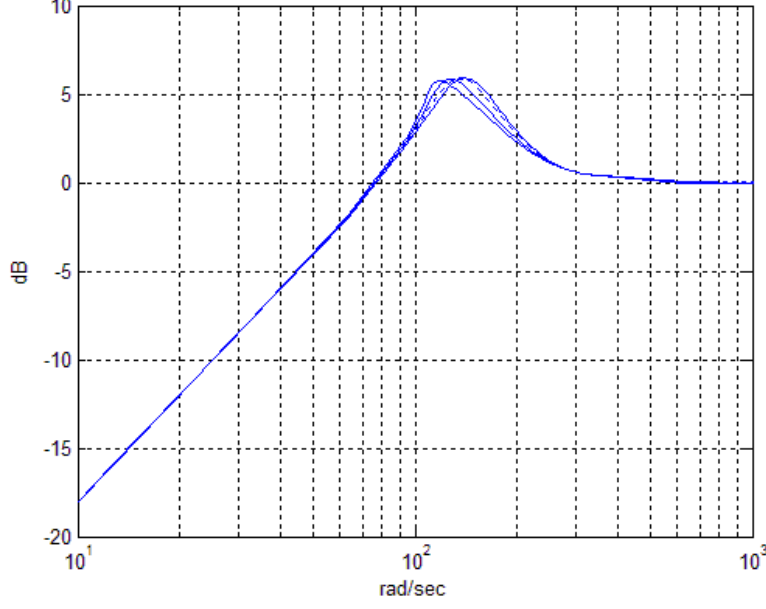
Figure 5. Sensitivity plots of the real nonlinear system.